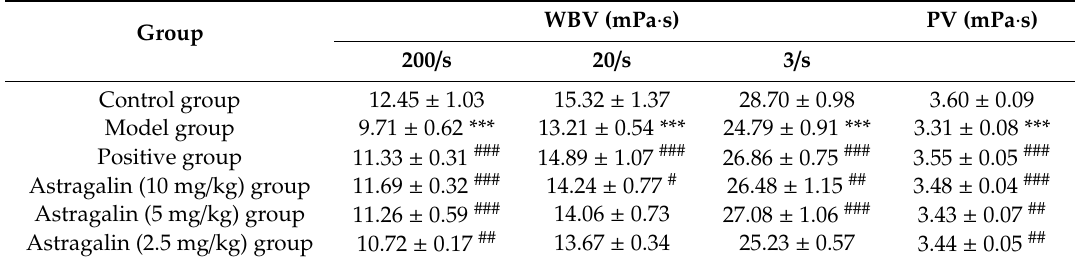
Table 8. E ff ects of astragalin on WBV and PV (X ± SD, n = 8).